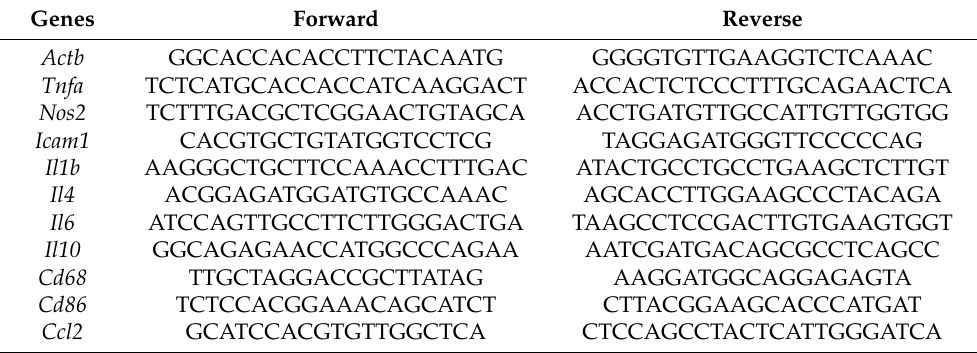
Table 1. Primer sequences for